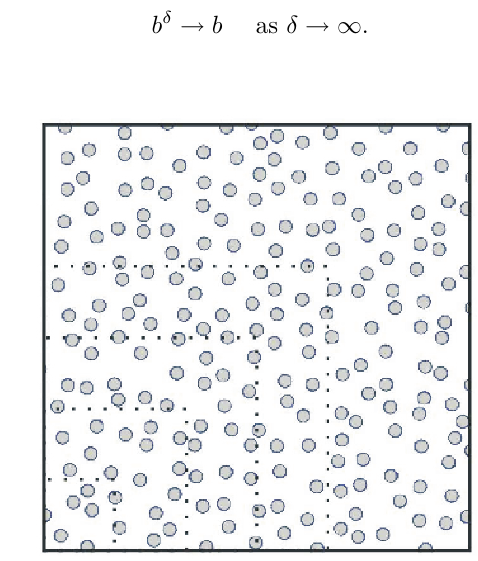
Figure 2 . A typical realization for the case when Ω Ω ∞ = [0 , 1] 2 for κ =